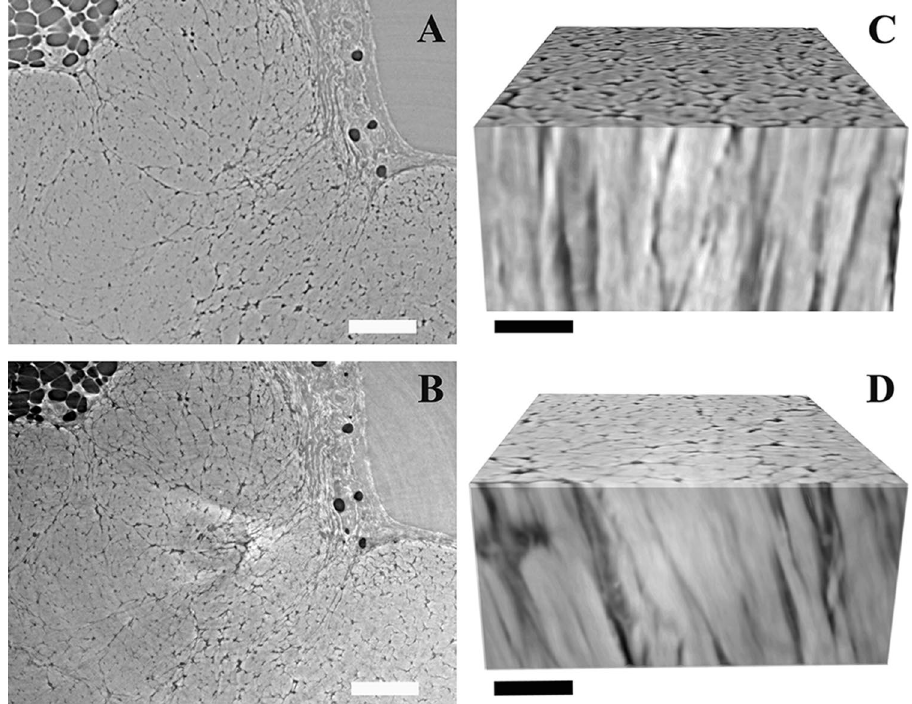
Figure 7. Tendon fibers visualization using two different imaging setups. Cross-sectional view of collagen fibers in the same sample imaged by ( A ) HNAM and ( B ) HRM. 3D renderings of the fibers imaged with ( C ) HNAM and ( D ) HRM. Scale bars: ( A , B ) 150 µm and ( C , D ) 50